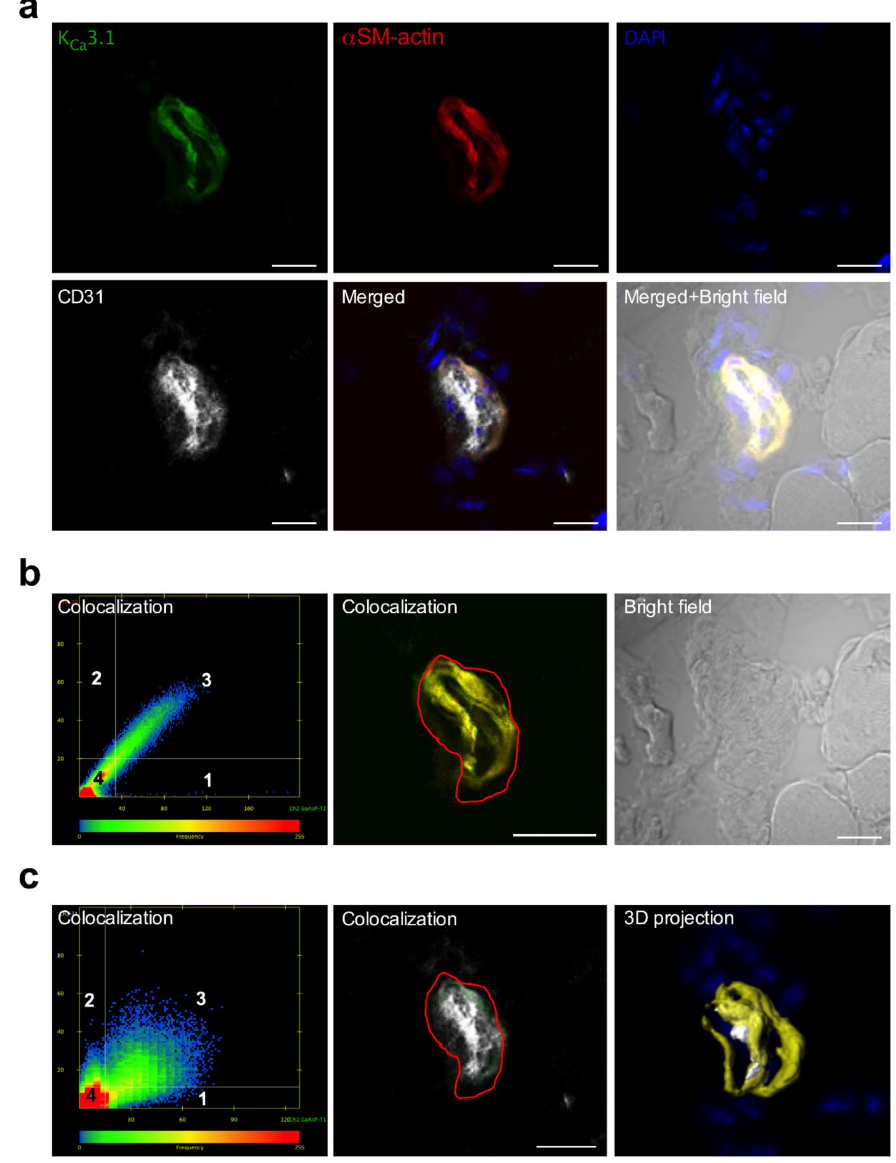
Figure 2. Localization of K Ca 3.1 in ECs and SMCs of murine collateral arteries. ( a ) Representative confocal immunofluorescence images of transversal sections of collateral arteries isolated 3 h after induction of arteriogenesis. Tissue sections were stained with an antibody against K Ca 3.1 (green), together with the SMC marker α SM-actin (red), the EC marker CD31 (grey), and DAPI (blue); ( b , c ) Scatterplots showing the colocalization analysis, (left lower panel) represents pixels that have low intensity levels in both channels, green and red ( b ), or green and gray ( c ). Quadrant 4 (lower left bottom) represents pixels that are referred to as background and are not taken into consideration for colocalization analysis. Quadrant 1 represents pixels that have high green intensities and low red intensities and Quadrant 2 represents pixels that have high red intensities and low green intensities. Quadrant 3 represents pixels with high intensity levels in both green and red (b) or green and gray ( c ). These pixels are considered to be colocalized. Bright field image is also displayed. ( c ) 3D projection surface rendering is showing the localization of the K Ca 3.1 with the labelling CD 31 and α SM-actin display on the panel ( c ) right lower position. Scale bar 20 µ